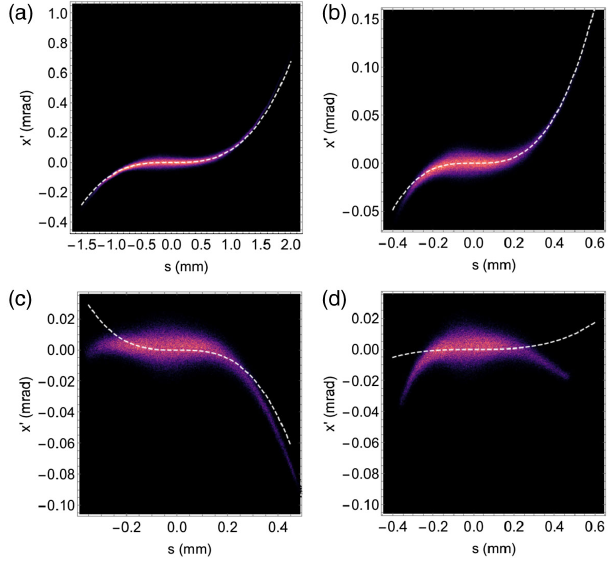
FIG. 4. From ELEGANT simulations: (a) Correlated kick from the first octupole ( s vs x 0 ) with the analytical estimate from Eq. (10) (white dashed), (b) Kick from the second octupole with first octupole off with the analytical estimate from Eq. (12) (white dashed), (c) Kick from the first octupole transported to the second octupole entrance with the analytical estimate from Eq. (11), (d) Combined kick from the first and second octupoles with octupole strengths chosen to minimize projected emittance of the core of the beam. The bunch head is on the left in all plots.